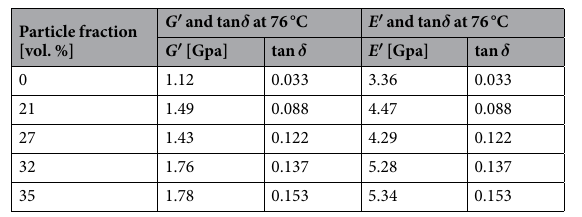
Table 1. Measured and calculated peak viscoelastic moduli for composites with the various particle fractions manufactured in this study, assuming E ′ ≈ 3 G ′ . The measured moduli are given at a chosen temperature of 76 °C, which is the peak position for most of the composites’ samples.